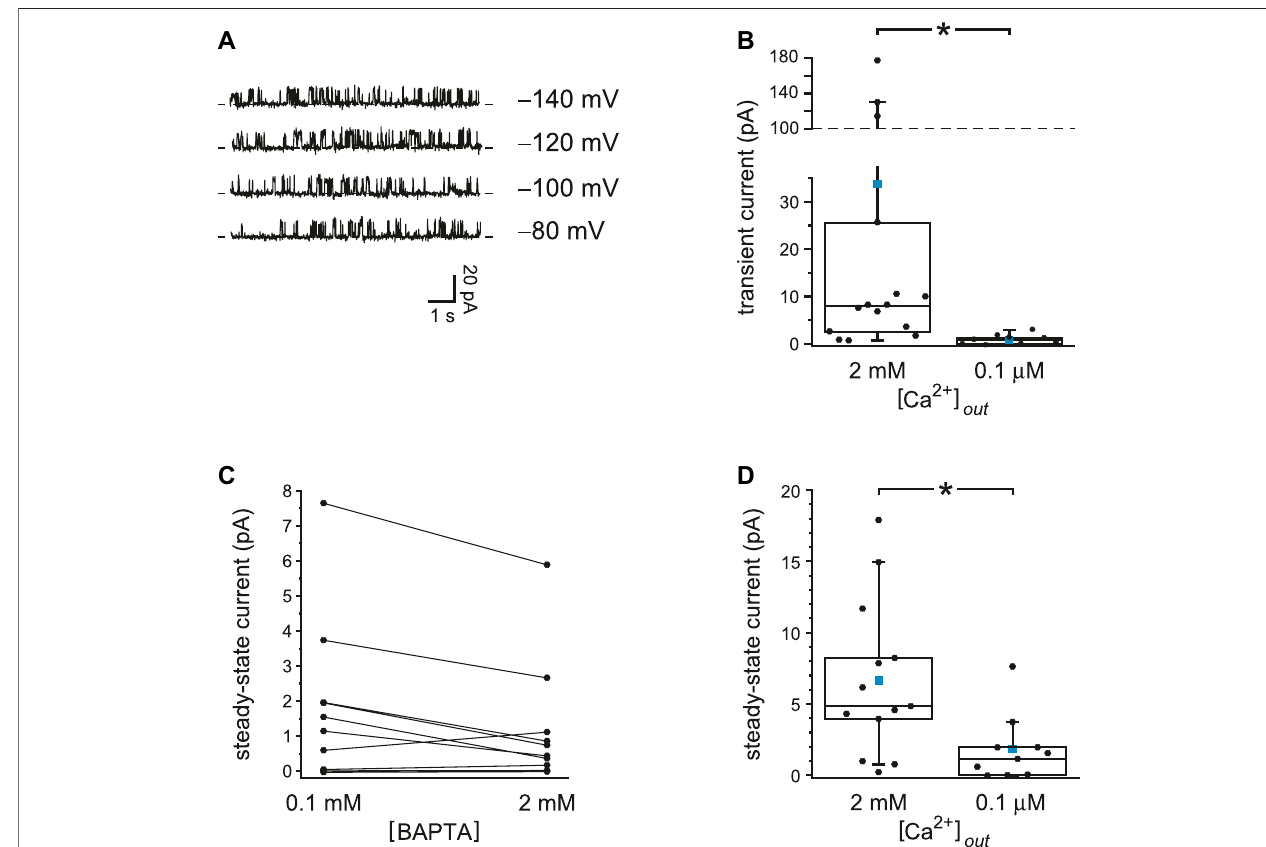
FIGURE 5 | With reduced external Ca 2+ , PC2 current is insensitive to Ca 2+ buffering. (A) The recordings shown were made at +60 mV immediately following a prepulse of 10 s to the voltages shown. The internal solution contained 0.1 mM BAPTA and 15 nM free Ca 2+ and the external solution 0.1 µM free Ca 2+ . (B) Transient current amplitudes for cilia tested with either 2 mM ( n = 15 cilia) or 0.1 µM ( n = 9 cilia) external free Ca 2+ ; the internal solution contained 0.1 mM BAPTA. Voltages were chosen that gave the greatest transient current. Prepulse voltages ranged from − 140 mV to − 40 mV and postpulse voltages from +40 mV to +80 mV. The values forciliain2 mMexternalCa 2+ aretakenfrom Figure1D .* p < 0.001. (C) Pairedmeansteady-statecurrentsfor10cilia,eachtestedinboth0.1and2 mMinternalBAPTA; theexternalsolutioncontained0.1 µMfreeCa 2+ .Voltageswerechosenthatgavethegreatestdifferenceinmeancurrentbetween0.1and2 mMBAPTAandwereeither +40 or +60 mV. (D) Mean steady-state currents for cilia tested with either 2 mM ( n = 13 cilia) or 0.1 µM ( n = 10 cilia) external free Ca 2+ ; the internal solution contained 0.1 mM BAPTA. The values for cilia in 2 mM and 0.1 µM external Ca 2+ are taken from Figure 2D and Figure 5C , respectively. In the box plots, the individual data are shown as fi lledcircles.Thetop,middle,andbottom linesindicate the75th,50th, and25thpercentile values,respectively.Whiskersindicatethe90thand 10thpercentile values. A blue square is shown at the level of the mean value. * p = 0.0099.